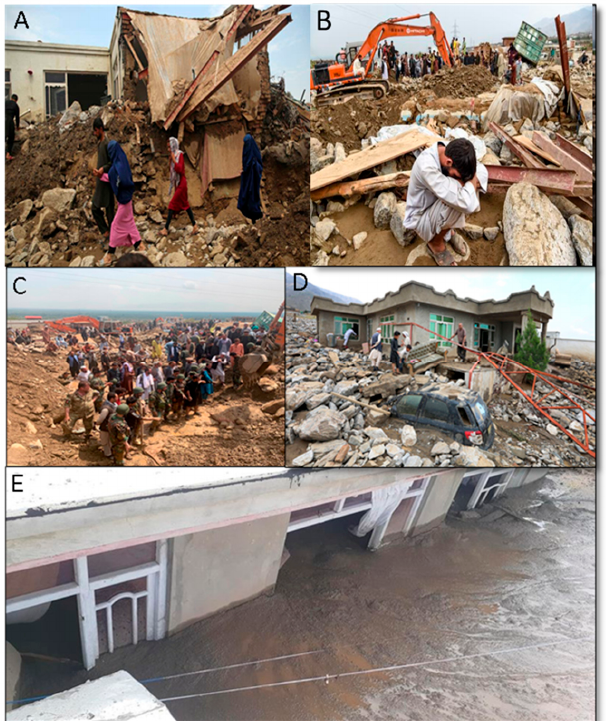
Figure 3. The affected area in Charikar: ( A ) group of people walk near damaged houses in Charikar, Parwan province, on Wednesday, 26 August 2020. The image is reprinted/adapted with permission from Ref [38], which can be accessed through Fox News. ( B ) A man reacts near to his ruined home as rescuers search for victims in Sayrah-e-Hopiyan, Charikar, Parwan province, on August 26, 2020, following a flash flood, photograph is reprinted/adapted with permission from Ref [39]. ( C ) Villagers and soldiers search for victims in a mudslide caused by a flash flood at Sayrah-e-Opiyan in Charikar (Photo is re-printed/adapted with permission from Ref [40]). ( D ) A flash flood brought debris and boulders into the house, covered the car, and injured and killed people. (Photo is reprinted/adapted with per-mission from Ref [41]). ( E ) A general view of a building in Charikar, Afghanistan, covered in flooded debris from flooding on 26 August 2020, Reprinted/adapted with permission from Ref [36].